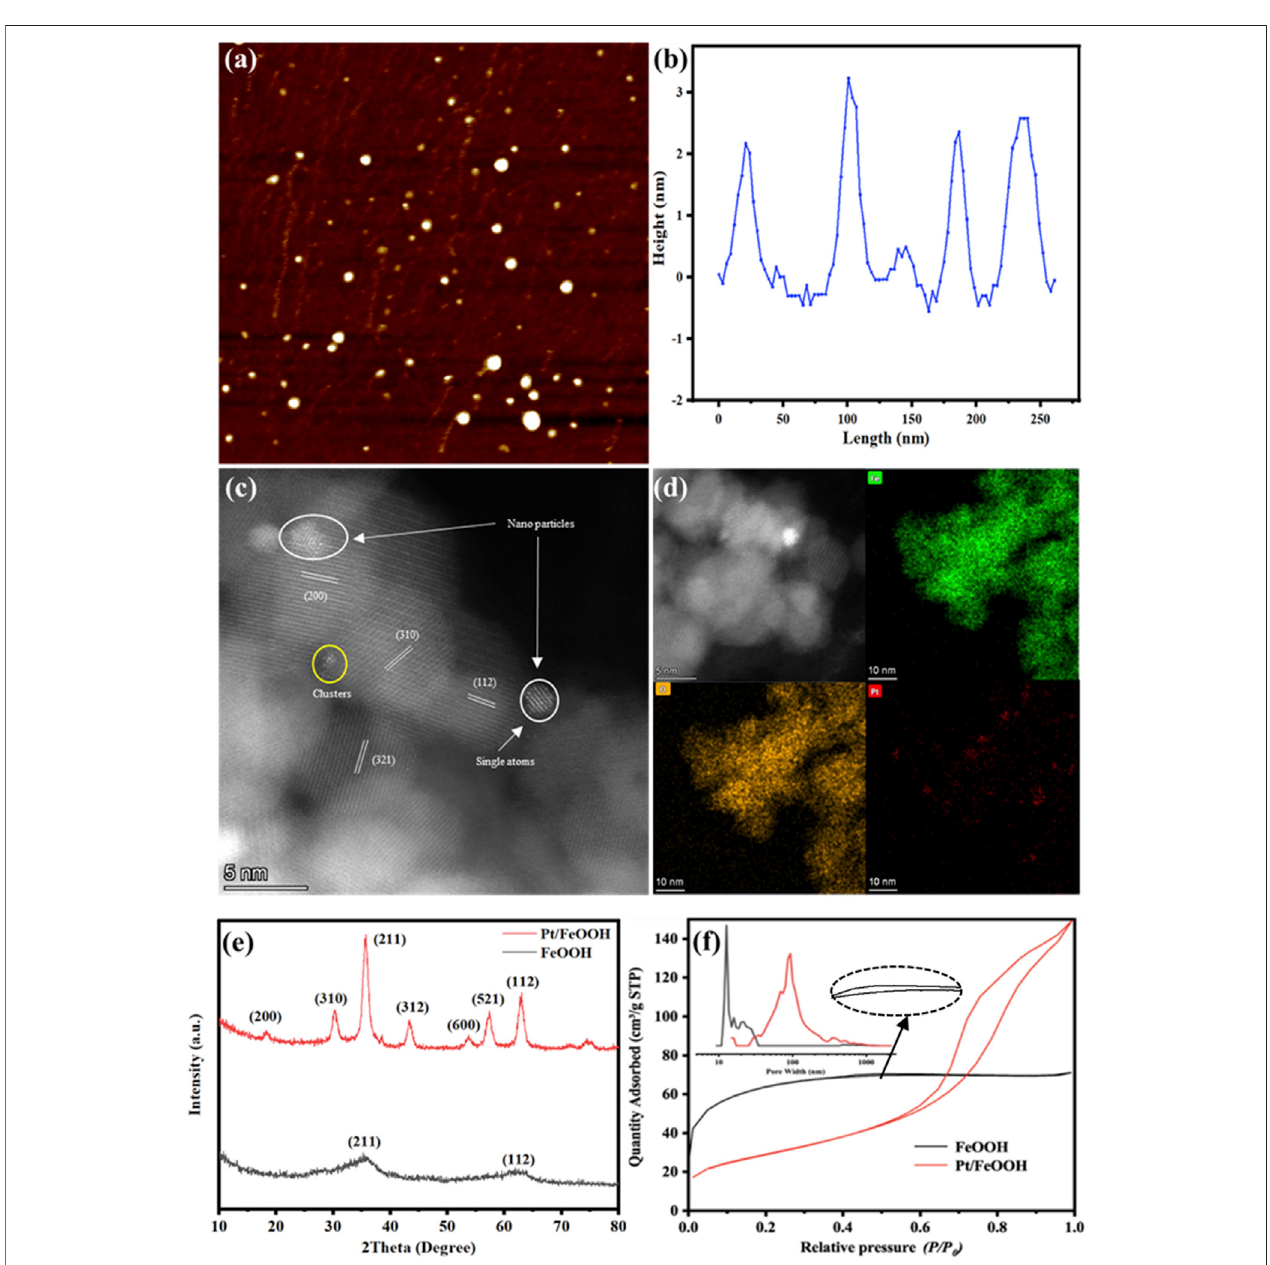
FIGURE 1 | (A) AFM image of FeOOH QDs. (B) Height distribution curves of FeOOH QDs. (C) AC STEM photos of Pt/FeOOH. (D) EDS photos and elemental mapping of Pt/FeOOH. (E) X-ray diffraction patterns of samples. (F) Nitrogen adsorption/desorption isotherms and the corresponding pore size distribution curves